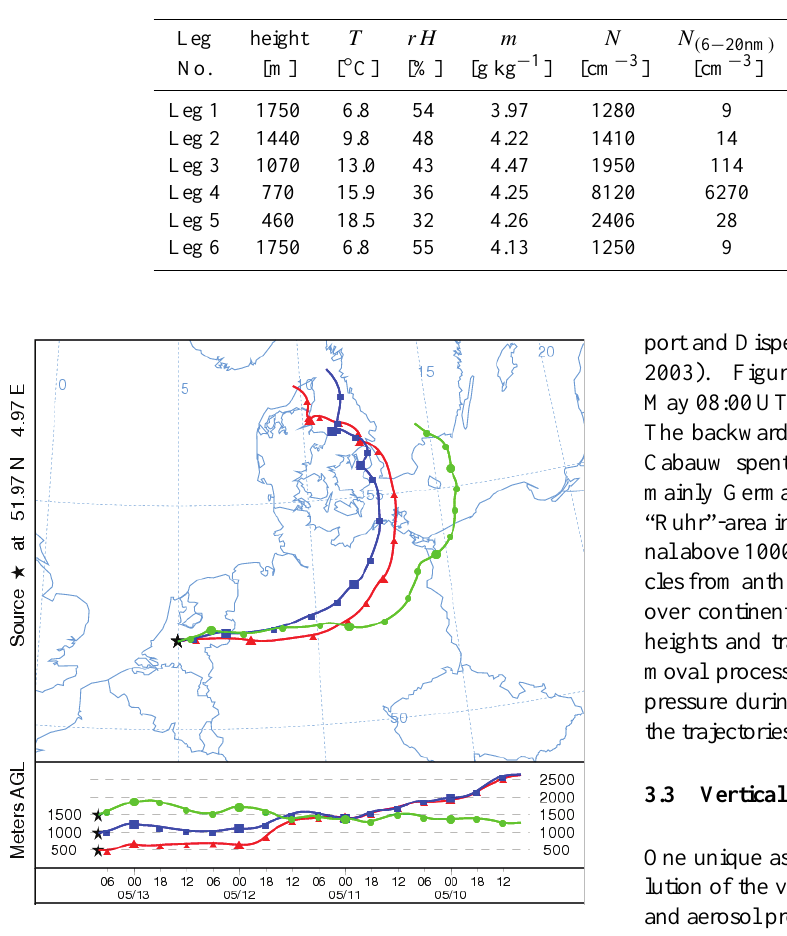
Fig. 2. 96h-backtrajectories arriving on 13 May 2008 at 08:00UTC at heights of 500, 1000, and 1500m over Cabauw calculated by HYSPLIT